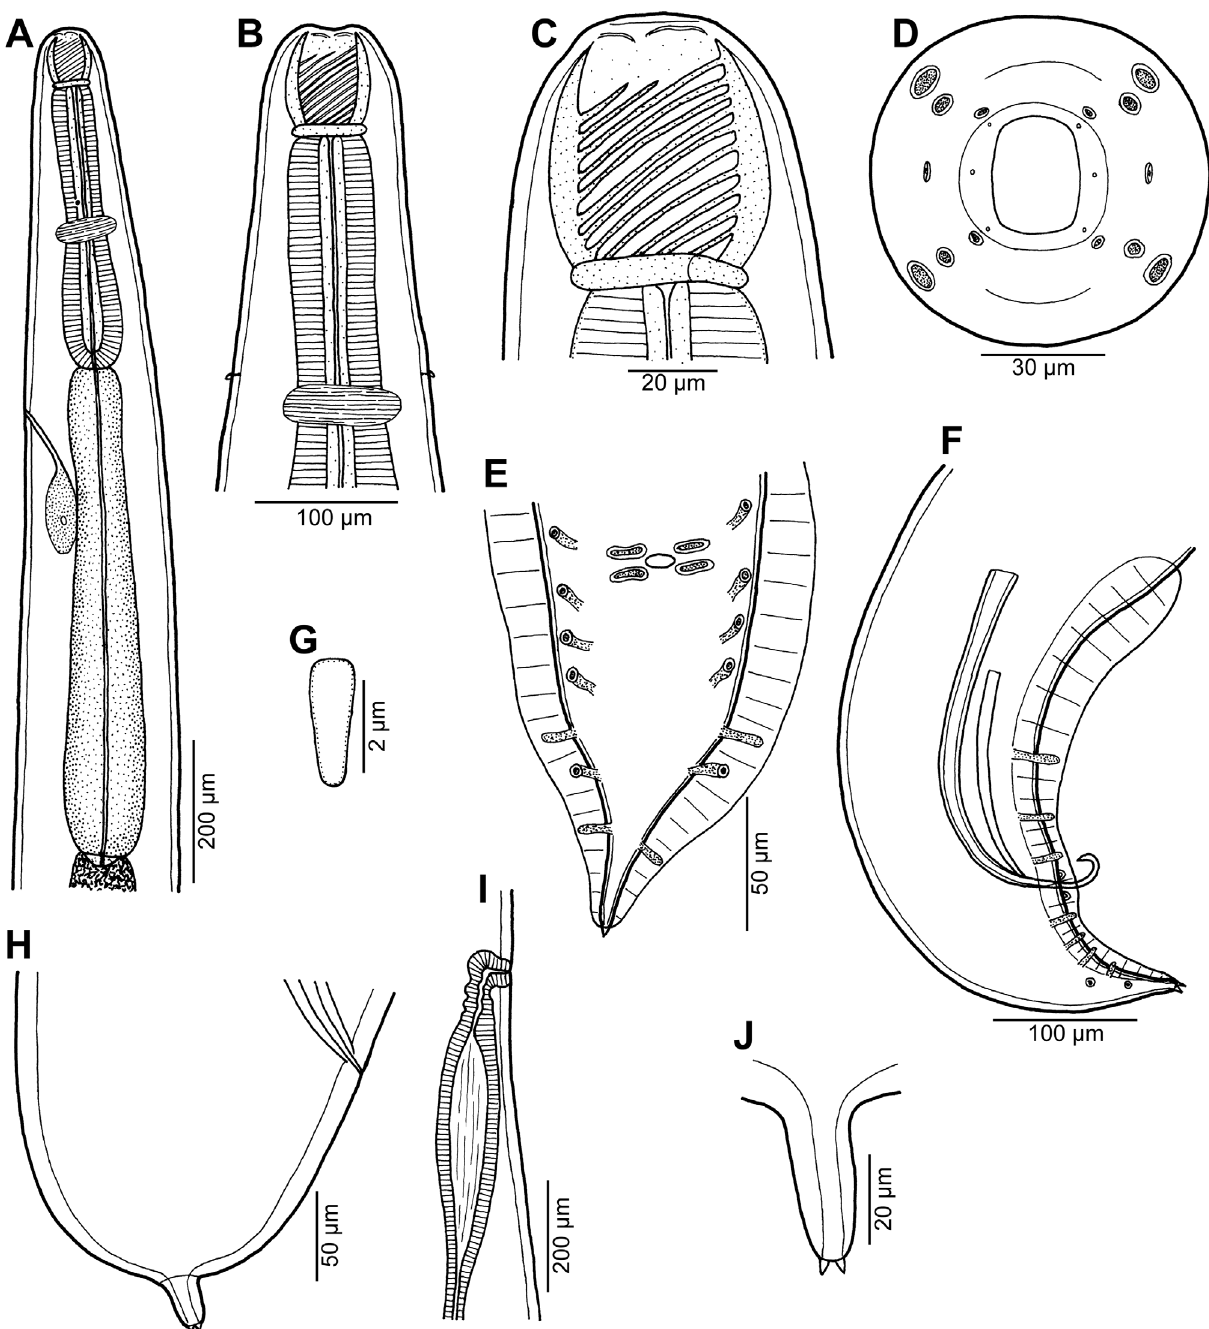
Figure 9. Procamallanus ( Spirocamallanus ) thalassomatis n. sp. from Thalassoma lutescens . (A, B) Anterior end of male, lateral and dorsoventral views, respectively; (C) buccal capsule of male, lateral view; (D) cephalic end, apical view; (E) tail of male, ventral view; (F) posterior end of male, lateral view; (G) deirid; (H) tail of female, lateral view; (I) vulva and distal end of vagina, lateral view; (J) tail tip of female, lateral